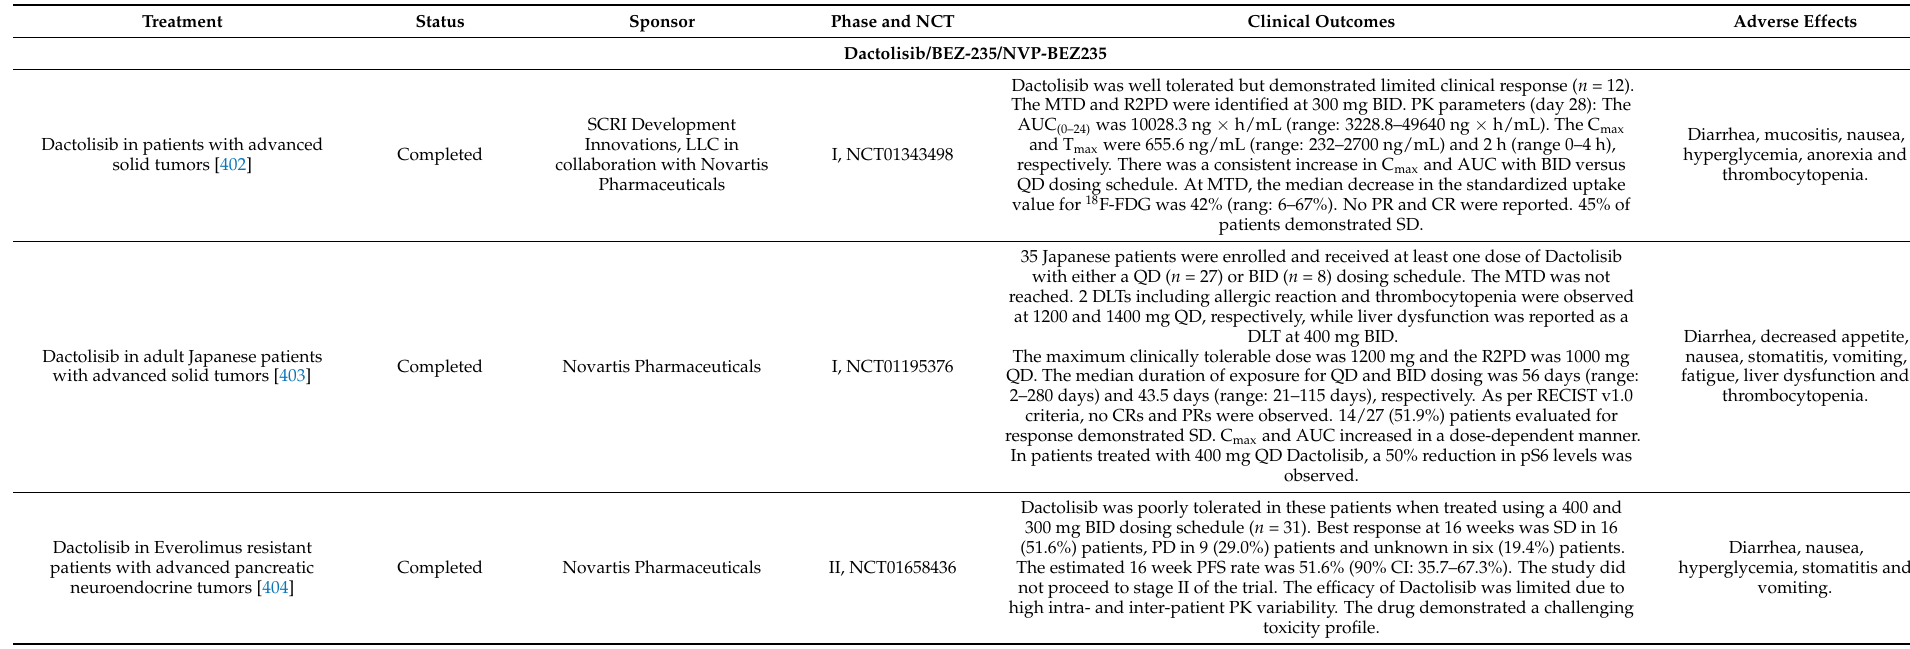
Table 3. Summary of trials, outcomes and adverse events associated with dual PI3K/mTOR inhibitors in various phases of clinical